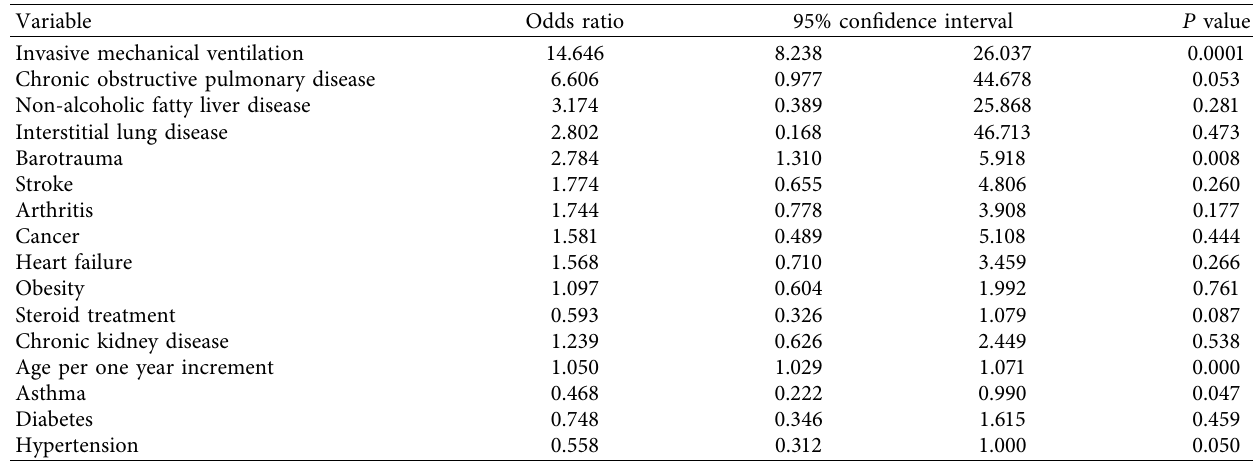
Table 4: Multivariable logistic regression analysis for the risk factors of hospital mortality. Variables entered in the model include obesity, corticosteroids, invasive mechanical ventilation, age, hypertension, diabetes, chronic kidney disease, interstitial lung disease, stroke, heart failure, barotrauma, chronic obstructive pulmonary disease, asthma, nonalcoholic fatty liver disease, arthritis, and cancer.